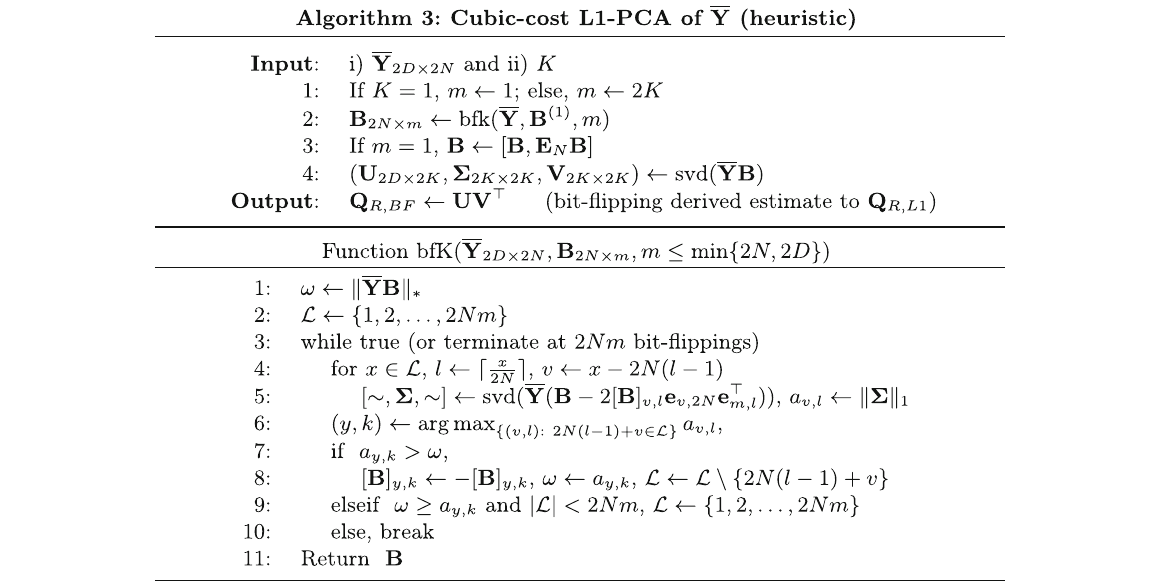
Fig. 4 Algorithm for estimation of the 2 K L1-PCs of rank-2 D data matrix Y 2 D × 2 N with cubic (w.r.t. N ) asymptotic complexity O K = 1; m = 2 K , for K > 1)